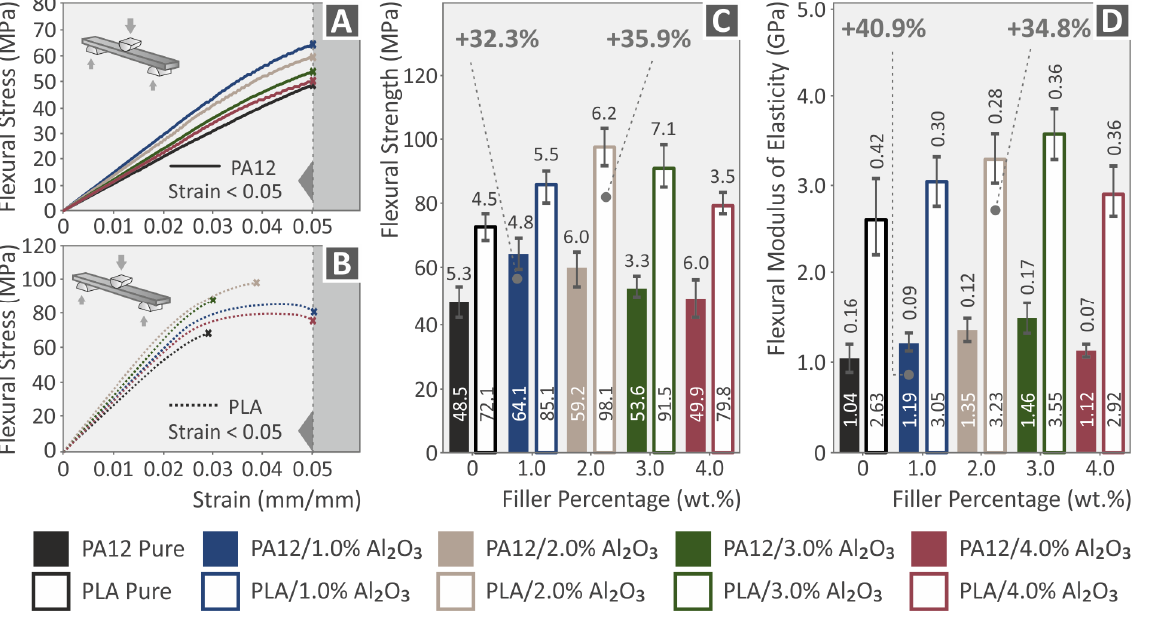
Figure 16. ( A , B ) Flexural stress (MPa) vs. strain (%) comparative and representative stress–strain curves for PA12 and PA12/Al 2 O 3 nanocomposites, as well as for PLA and PLA/Al 2 O 3 nanocomposites; ( C , D ) Average flexural strength and flexural modulus, along with the calculated standard deviation values, for 3DP PA12, PLA and all nanocomposites at 1.0, 2.0, 3.0, and 4.0 wt.% Al 2 O 3 filler loading. Legend shows which color corresponds to which material in each graph.